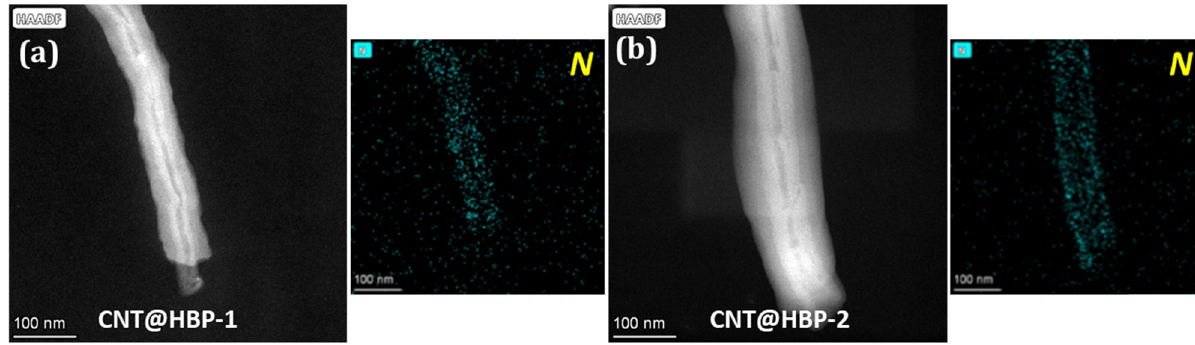
Figure 4: High - angle annular dark - fi eld STEM images and the corresponding EDX elemental mappings of ( a ) CNT@HBP - 1 and ( b ) CNT@HBP - 2.